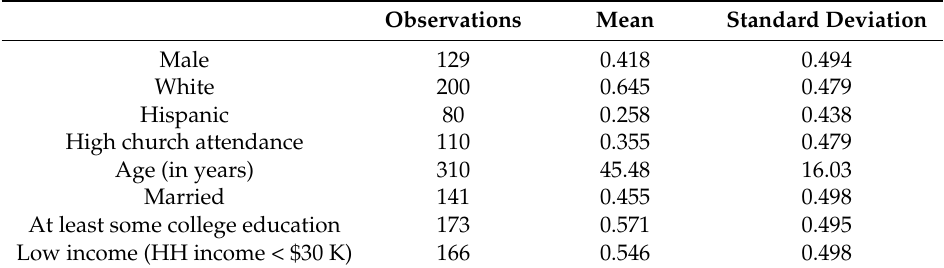
Table 2. Summary of demographic variables. ‡